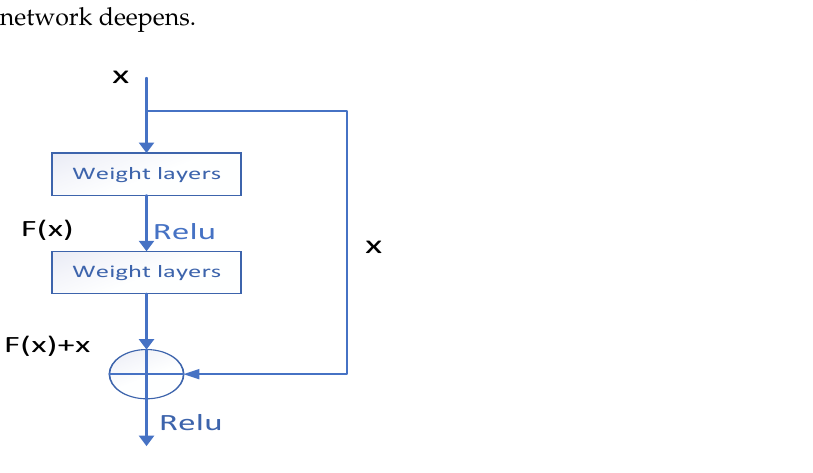
Figure 5. Residual